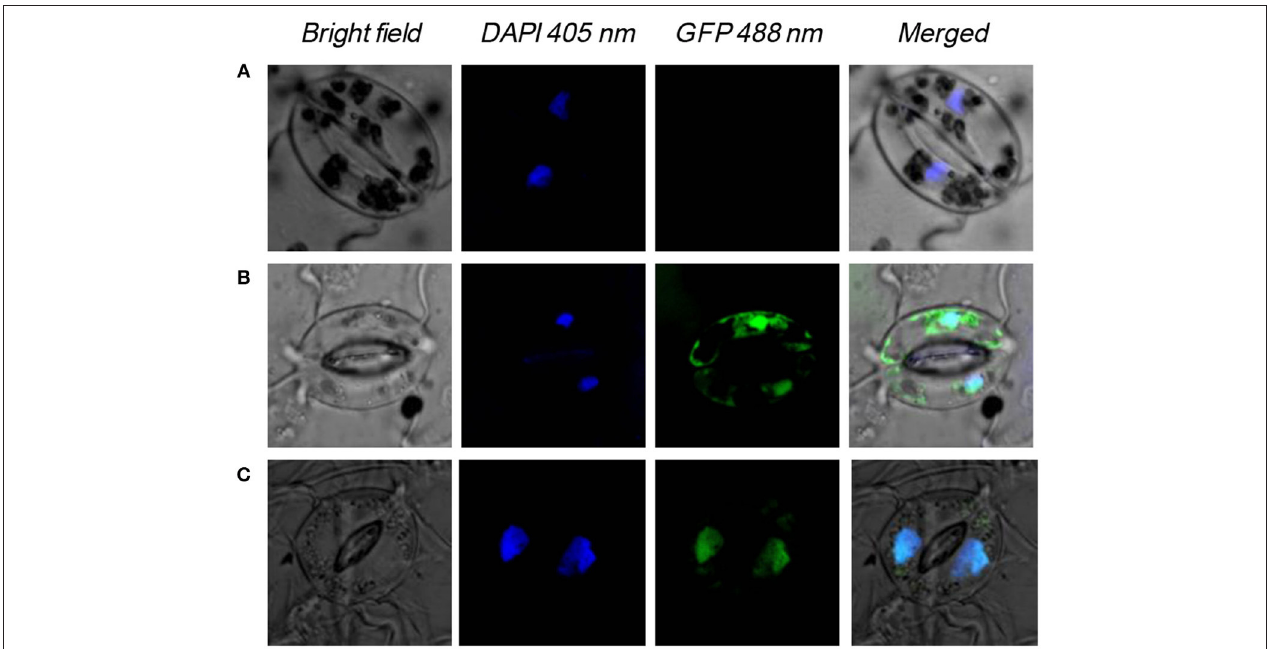
FIGURE 4 | Nuclear localization of NtWRKY-R1 in tobacco cells. (A) The control plant, (B) The transformed plant with p S1300:GFP vector, (C) the transformed plant with p S1300:NtWRKY-R1:GFP . The emission wave lengths of bright field, DAPI and GFP are 510, 405, and 488nm, respectively.